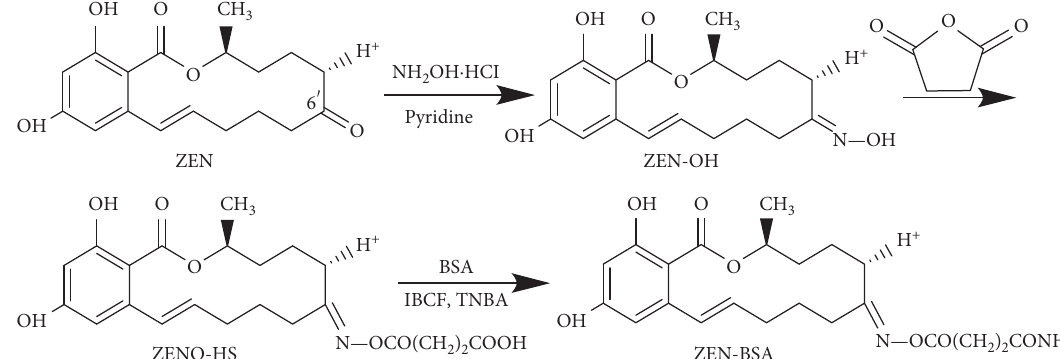
Figure 3: Synthesis route of the ZEN-BSA by the CMA